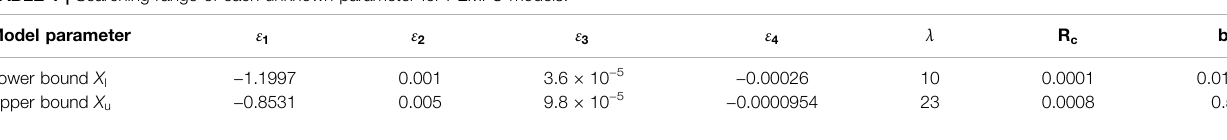
TABLE 1 | Searching range of each unknown parameter for PEMFC models. Model